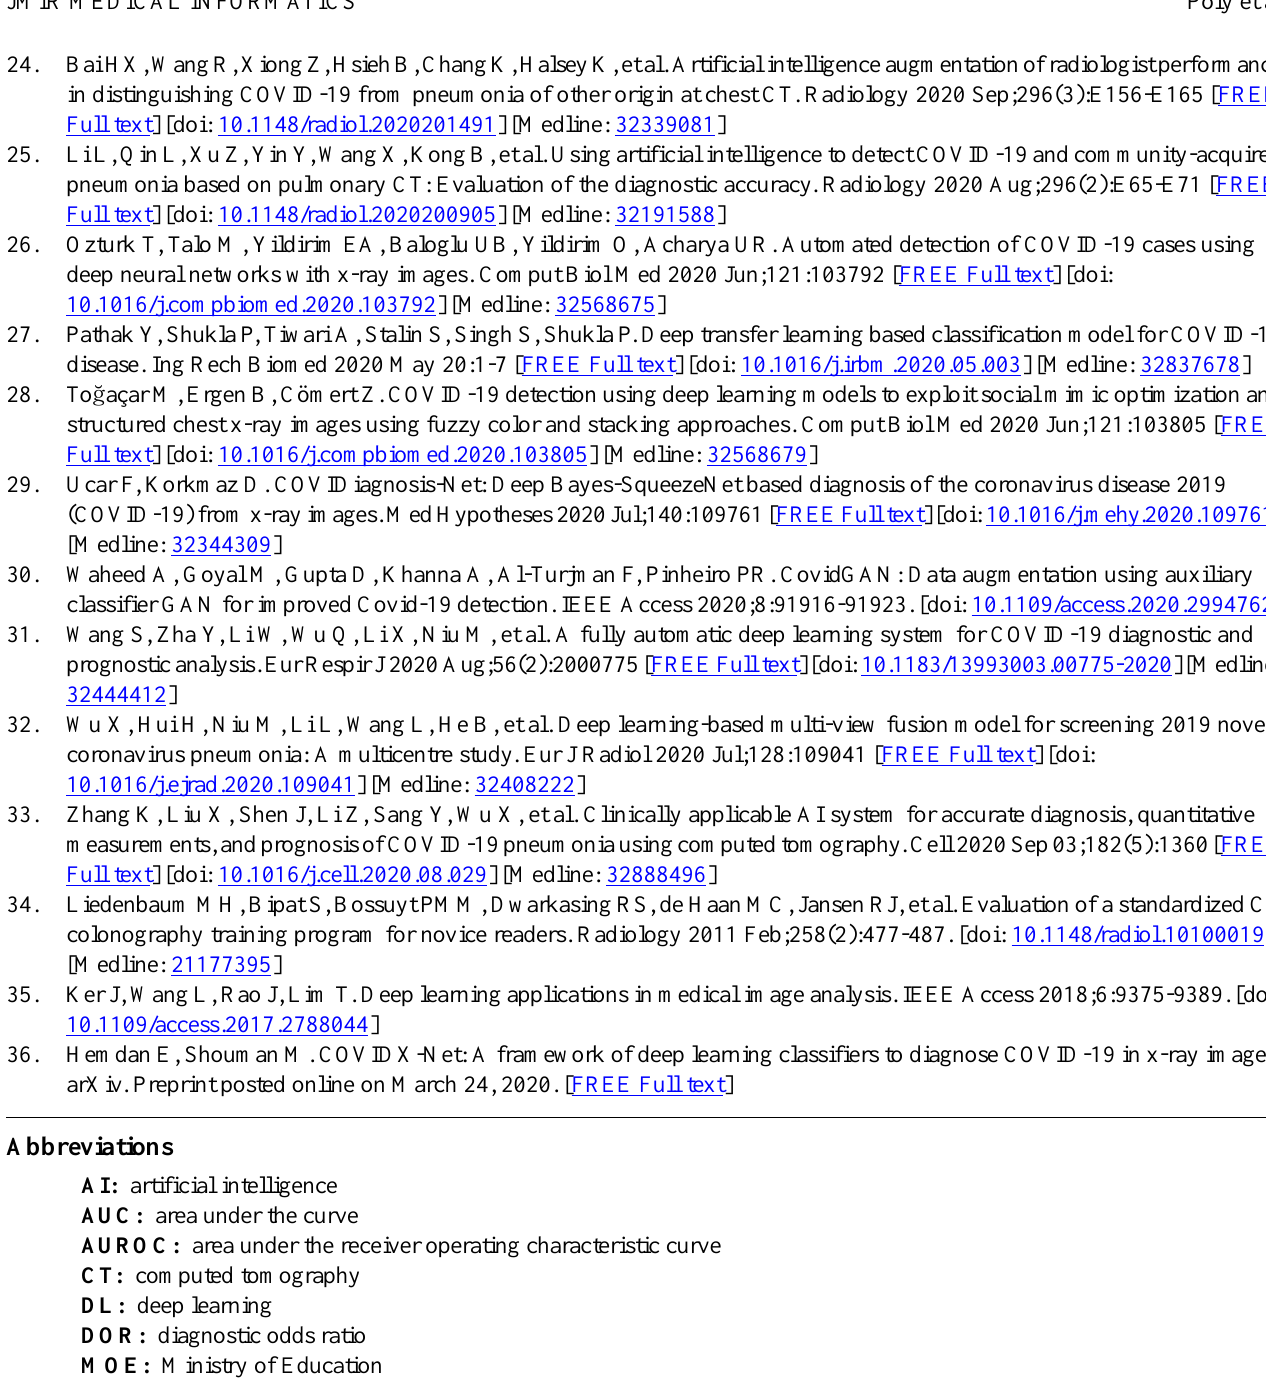
RT-PCR: reverse transcription–polymerase chain reaction SROC: summary receiver operating